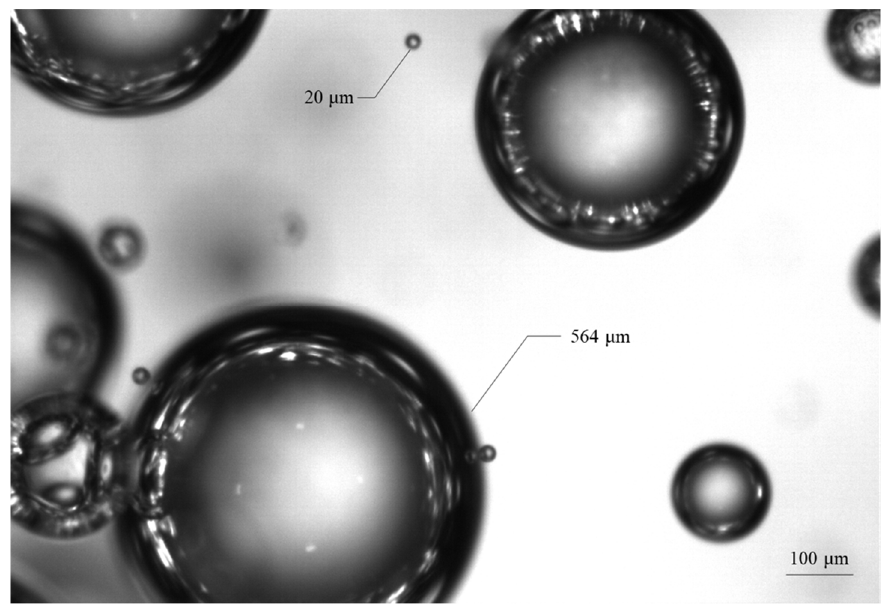
Figure 8. Bubbles captured with PVM